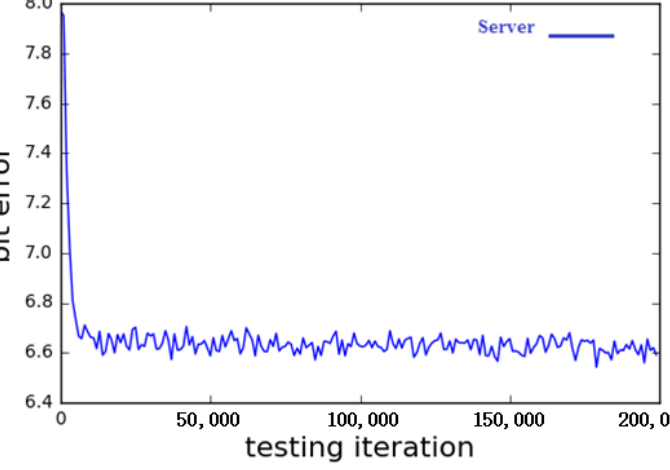
Figure 8. Evolution of Server Reconstruction Errors during Training.